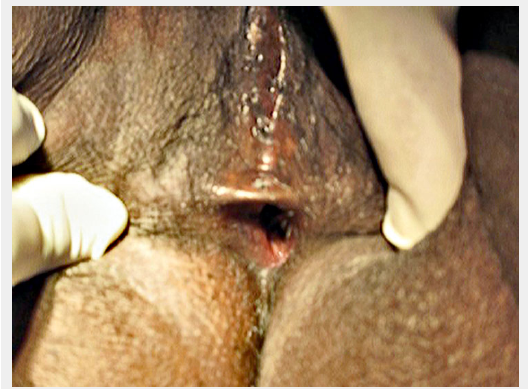
FGM/C type IIIb (virgin). Photo courtesy of Reference Centre for Preventing and Curing FGM, Department of Gynaecology, Perinatology and Physiology of Reproduction of Florence, Italy.